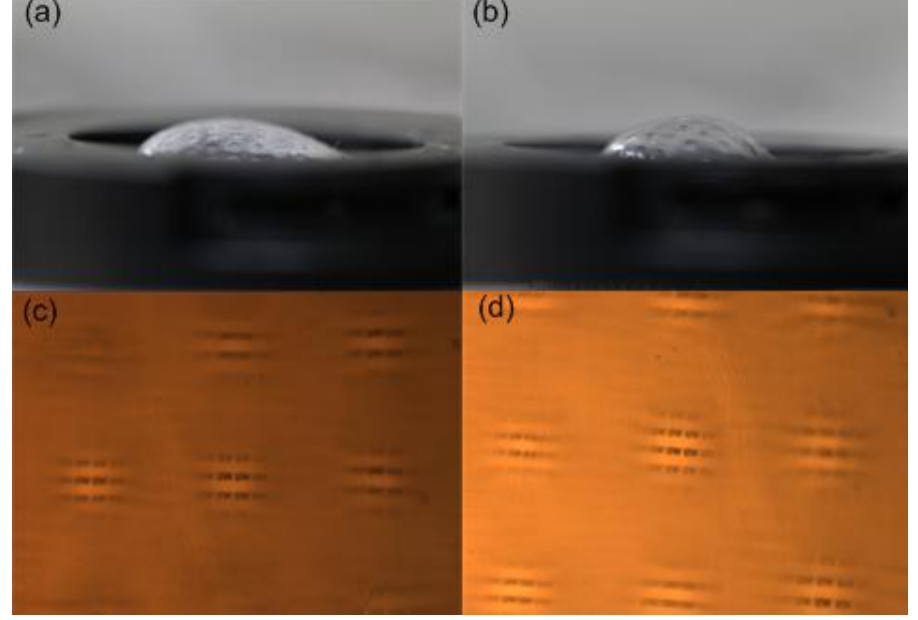
Figure 8. Artificial compound eye. ( a ) PDMS compound eye with 0.7-mm microlenses. Field of view achieved by the compound eye is 94°. ( b ) Solaris compound eye with 0.7-mm microlenses. Field of view achieved by the compound eye is 113°. ( c ) Images acquired by PDMS compound eye. ( d ) Images acquired by Solaris compound